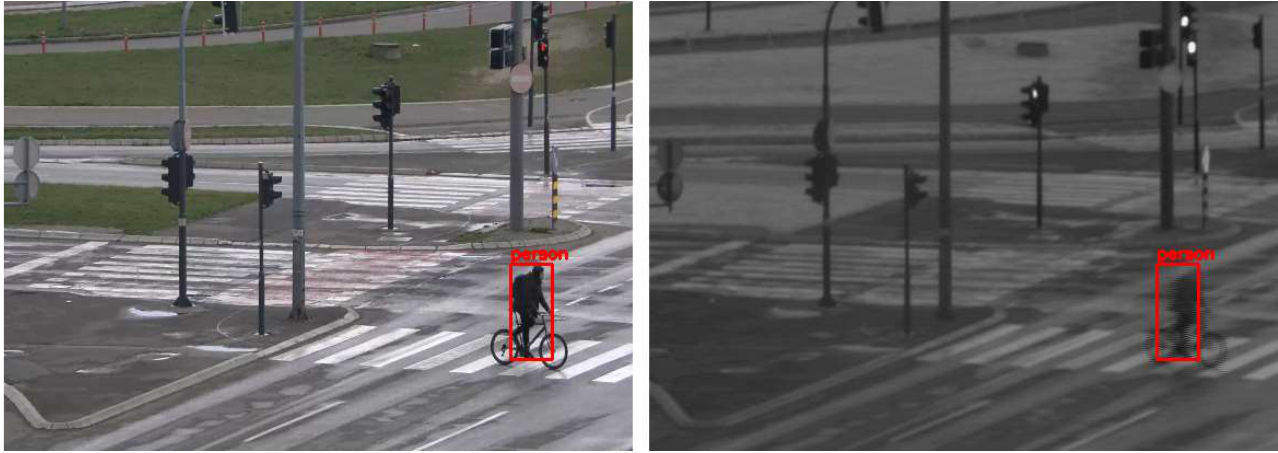
Figure 12. Inaccurately placed bounding box around a person in the SWIR image due to the detection of a moving person, and the method the image is created using an interlaced camera.